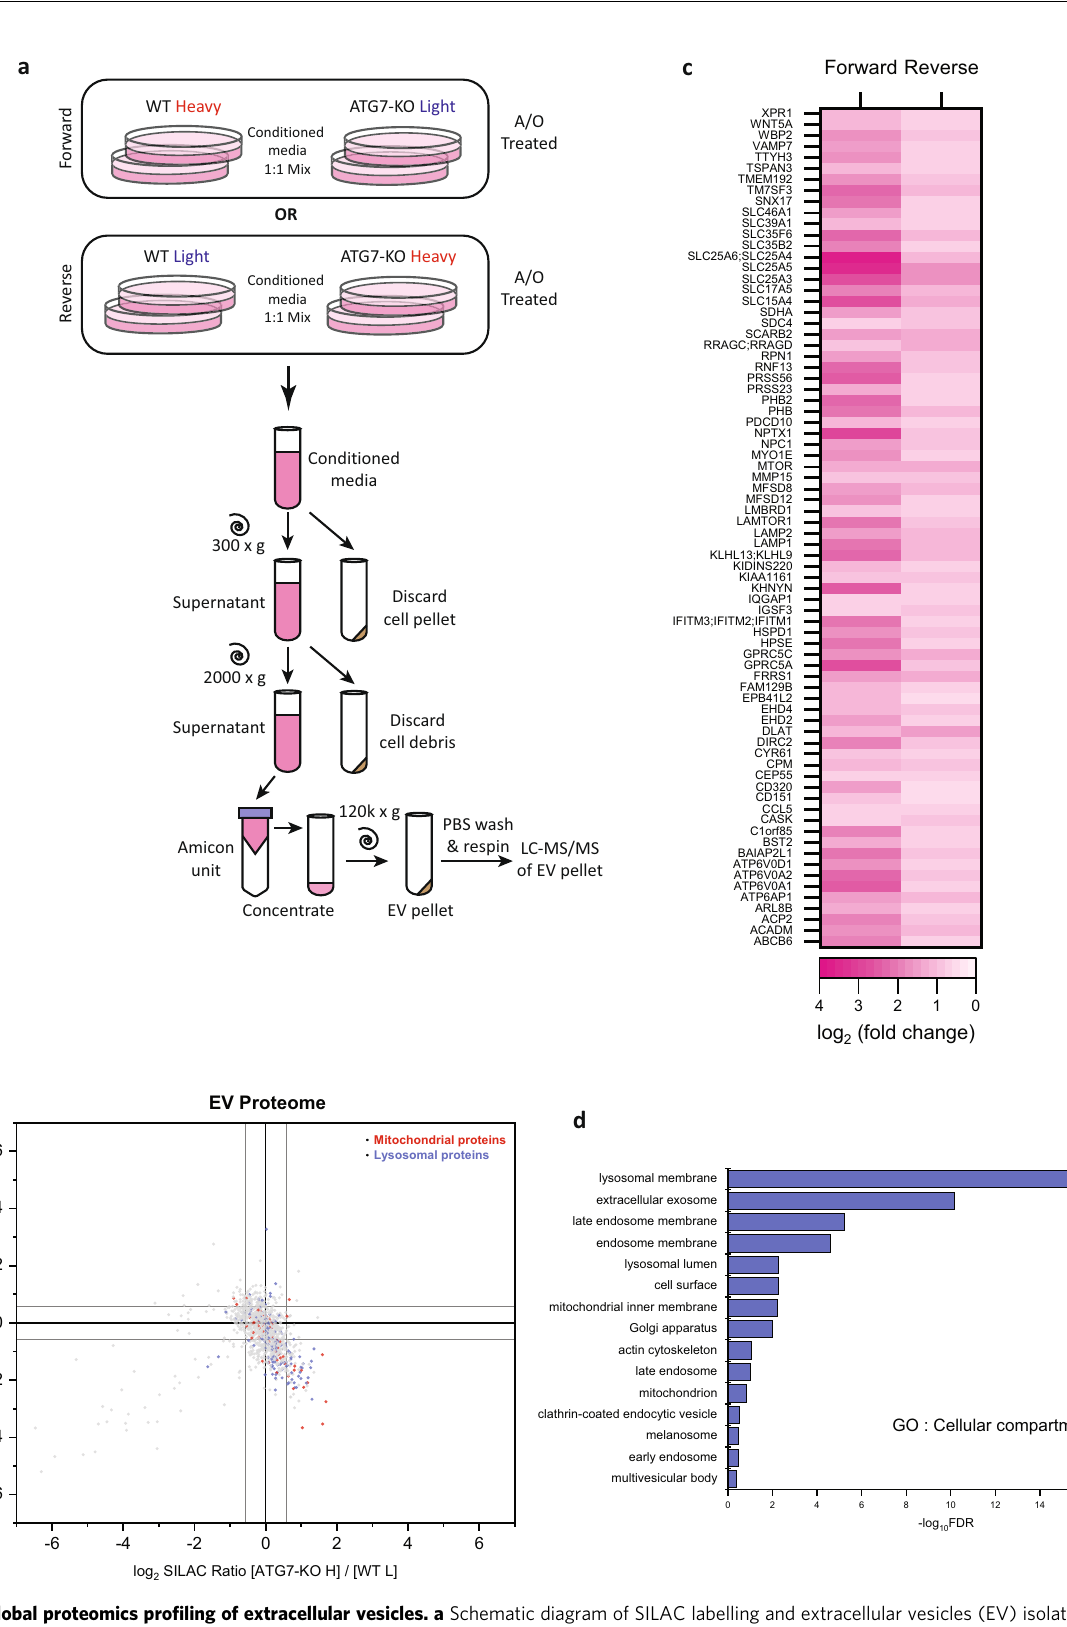
Fig. 3 Global proteomics pro fi ling of extracellular vesicles. a Schematic diagram of SILAC labelling and extracellular vesicles (EV) isolation. b log 2 [H/L] dotplot of EV proteins that had SILAC ratios in forward (WT heavy; ATG7-KO light) and reverse (ATG7-KO heavy; WT light) labelling experiments. Grey lines denote a 1.5× fold enrichment cutoff. c Heatmap of proteins identi fi ed to have a >1.5 fold enrichment when comparing ATG7-KO to WT EVs in both forward and reverse labelling experiments. d Gene ontology analysis (cellular compartment) of proteins that were enriched >1.5 fold in EVs of ATG7-KO vs. WT, plotted according to − log 10